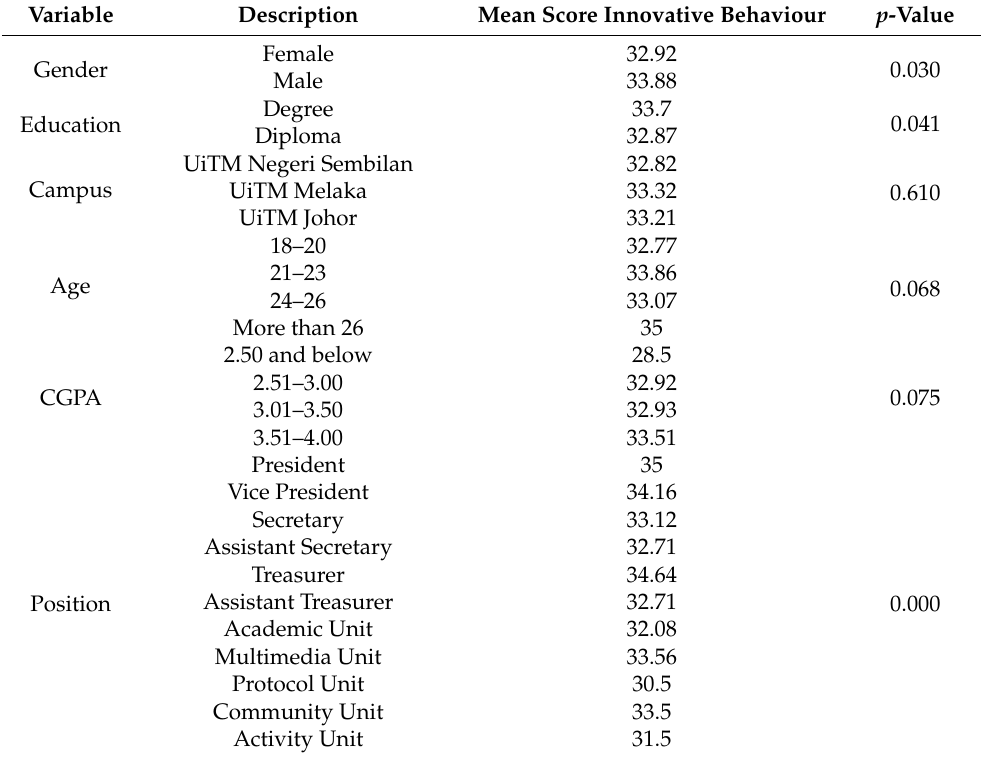
Table 3. Testing differences in innovative behaviour on demographic background using t -test and